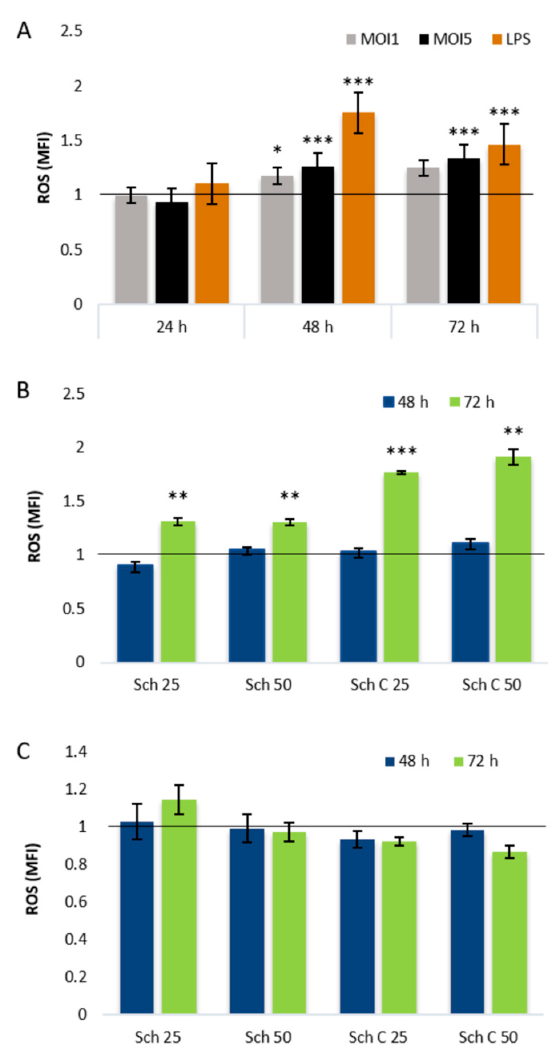
Figure 4. Impact of C. pneumoniae infection and dibenzocyclooctadiene lignans on intracellular ROS production. ( A ) THP-1 macrophages were infected with C. pneumoniae at MOI1 and MOI5 or treated with 1 µg/mL of LPS for 24, 48, or 72 h. ( B ) THP-1 macrophages were exposed to schisandrin lignans for 48 and 72 h. ( C ) THP-1 cells were simultaneously infected with C. pneumoniae and treated with schisandrin lignans for 48 and 72 h. Intracellular ROS levels were measured after 30 min incubation with DCFH-DA and followed by 3 h incubation with PBS. Data are normalized to a 0.25% DMSO vehicle cell control ( A , B ) or infection control ( C ) and shown as a mean ± SEM (n = 4) statistical significance is presented as marks of p -values: <0.05: *; <0.01: **; <0.001: ***. Abbreviations: Sch = schisandrin, MOI = multiplicity of infection.